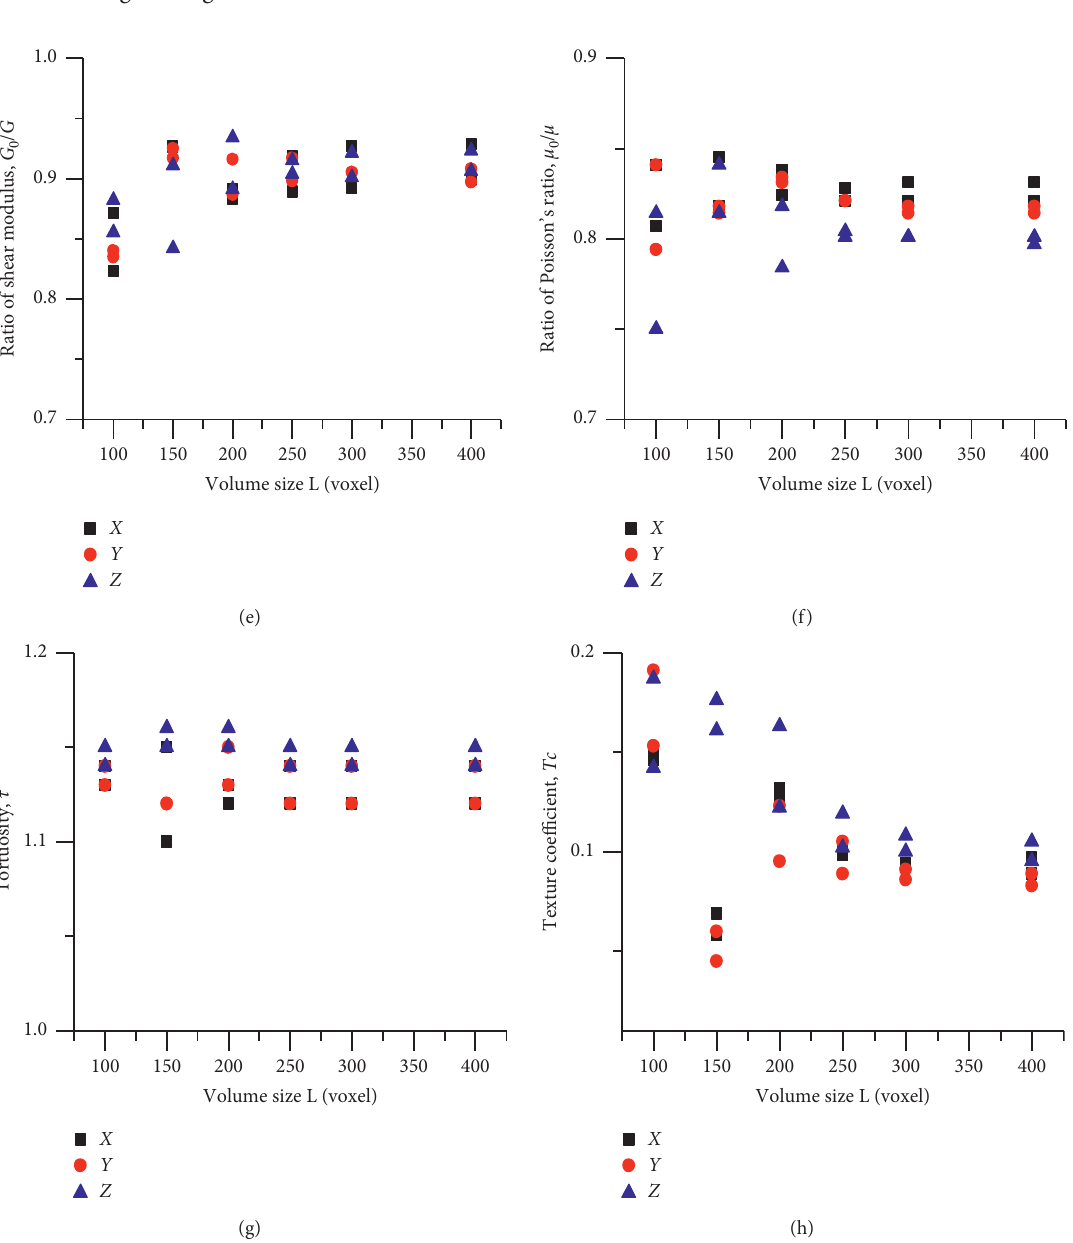
Figure 5: RVE analysis of mechanical properties and microstructure: (a) the model selection for RVE analysis and (b) ∼ (h) the ratio of Young’s modulus, ratio of compressive strength, ratio of yield strength, ratio of shear modulus, ratio of Poisson’s ratio, tortuosity, and TC against the model size for the RVE